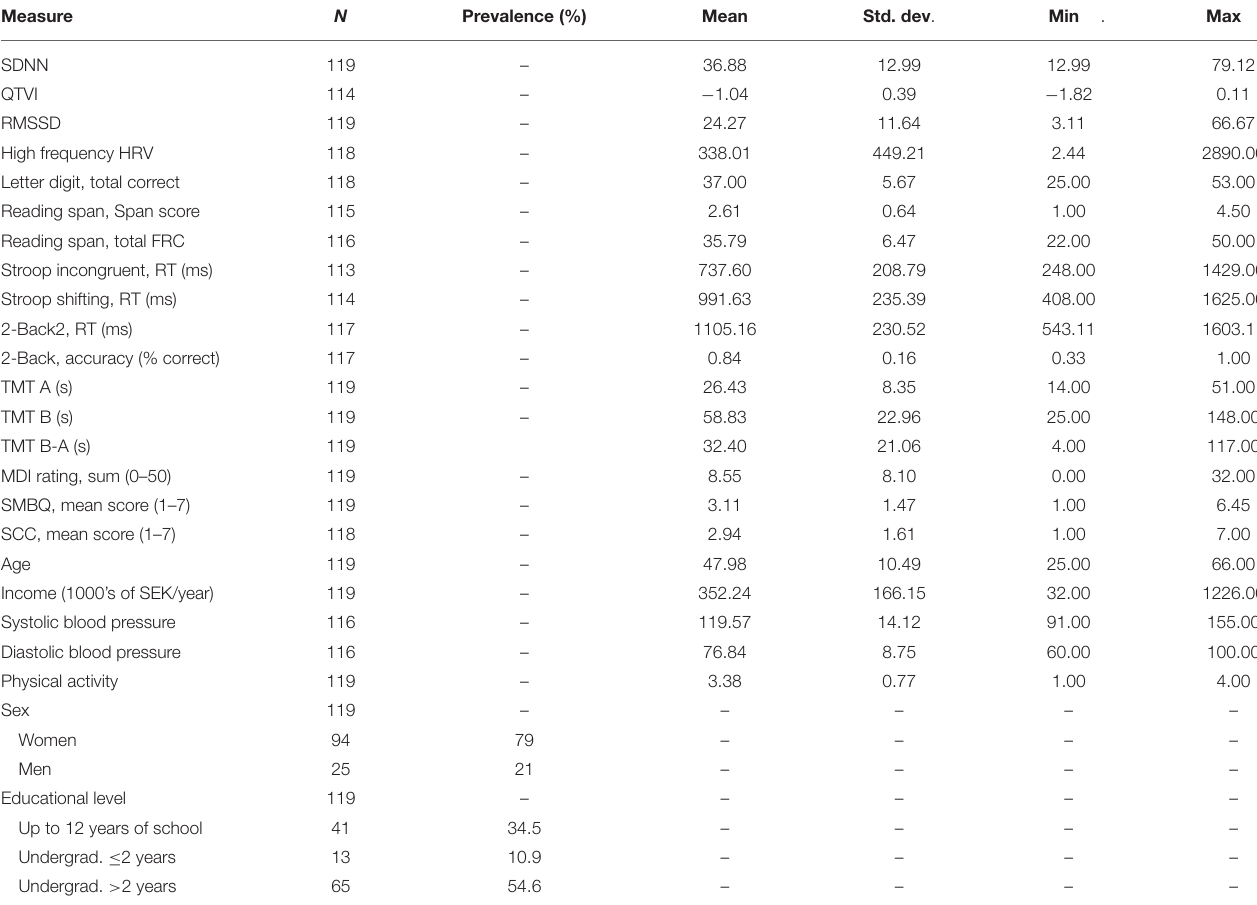
TABLE 1 | Descriptive statistics for the study